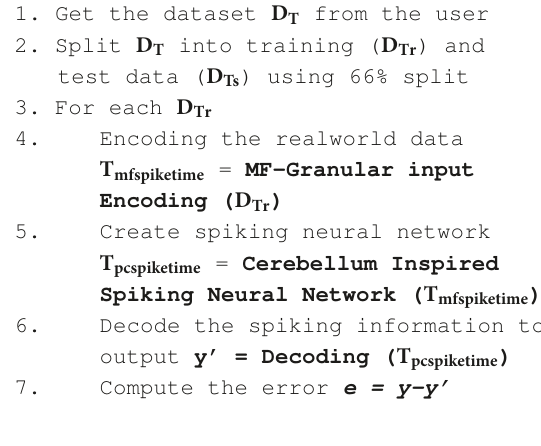
Algorithm 5: CISNN training and